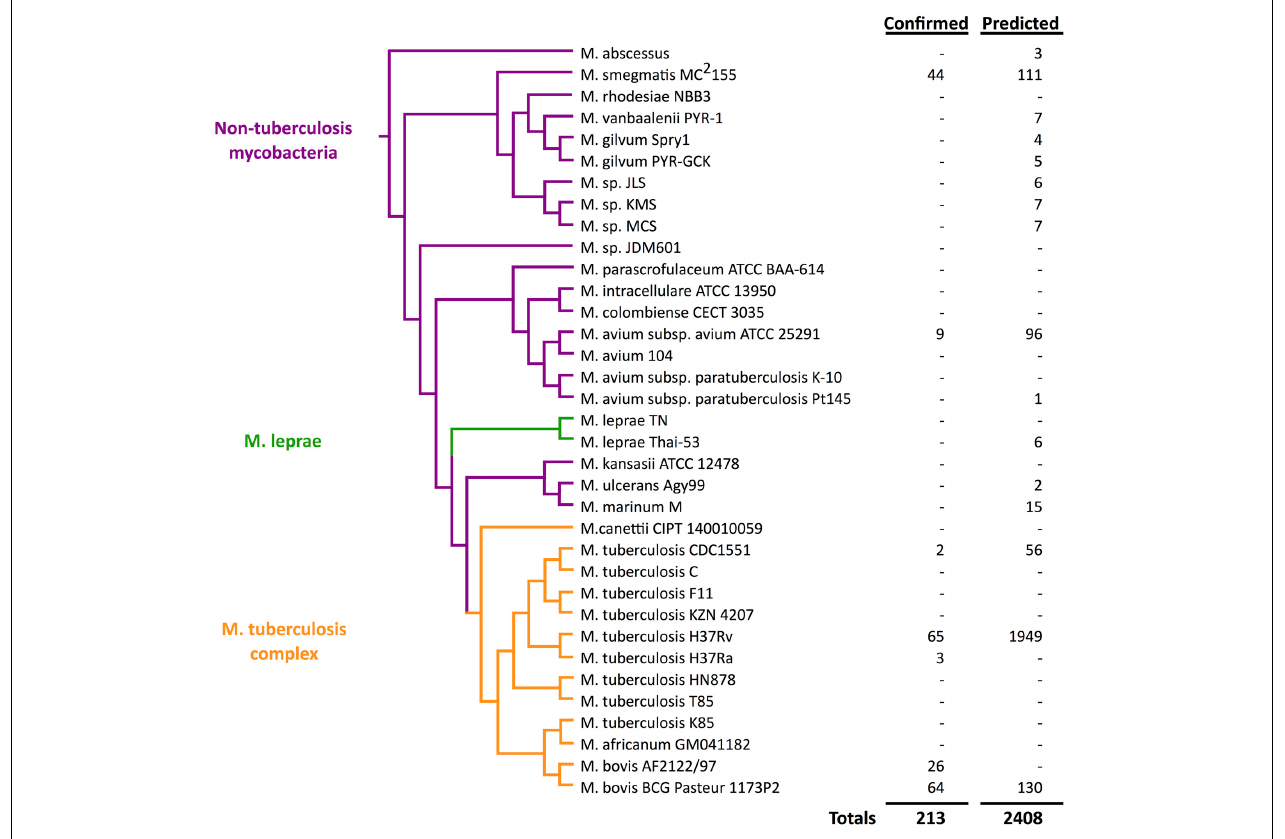
FIGURE 1 | Quantitative view of sRNA discovery in mycobacteria by phylogeny. Confirmed sRNAs have been experimentally validated while unconfirmed sRNAs include unverified computational predictions (Wattam et al.,